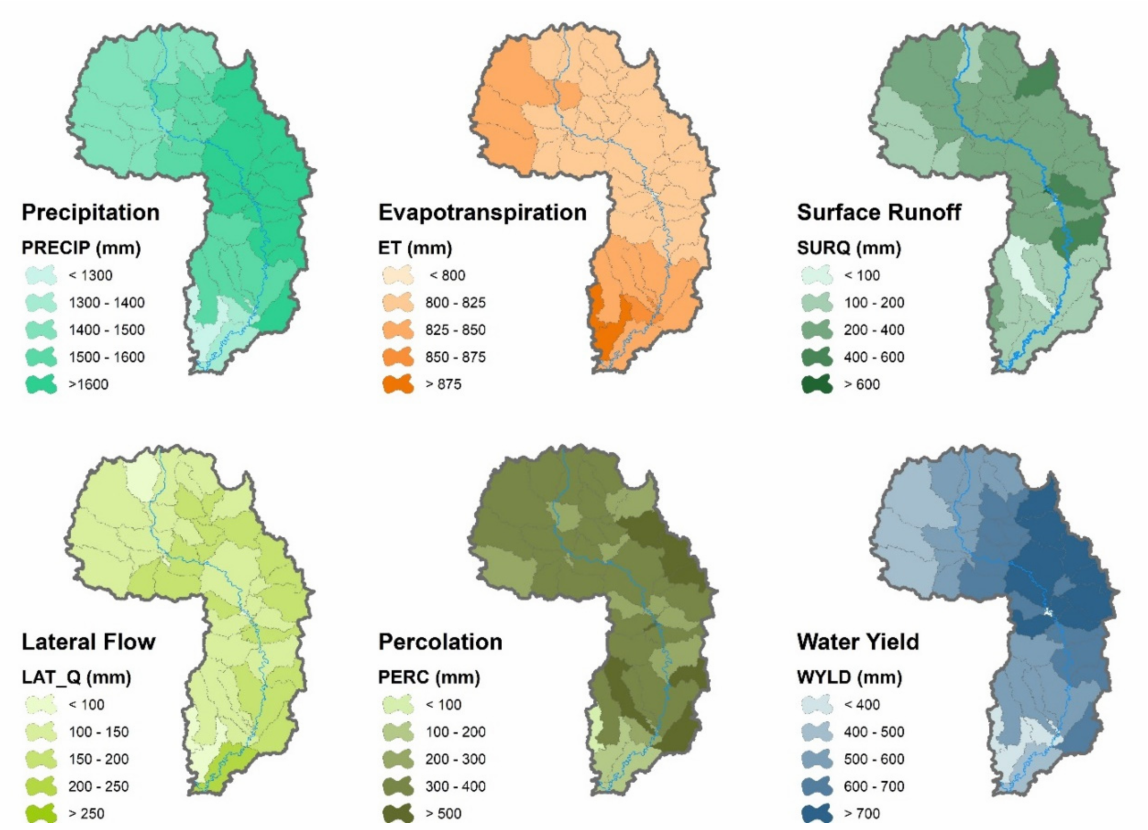
Figure 3. Water balance components on the Sen River Basin: Precipitation, Actual Evapotranspiration, Surface runoff, Lateral flow, Percolation, and Water yield of baseline period from